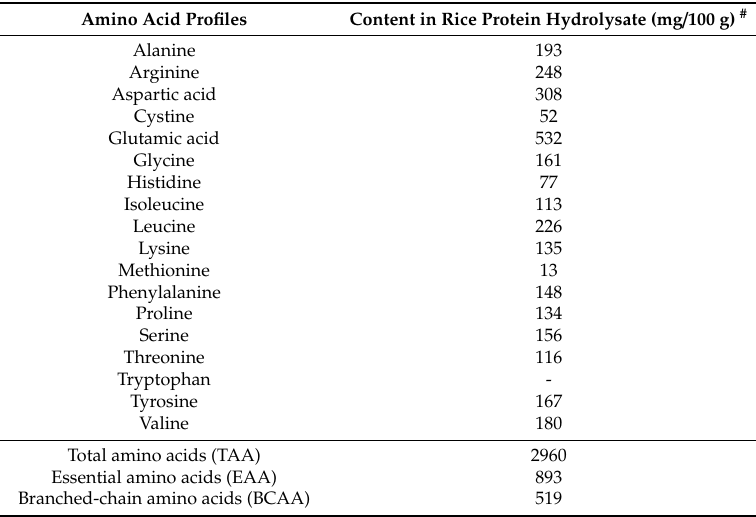
Table 1. Rice protein hydrolysate’s amino acid